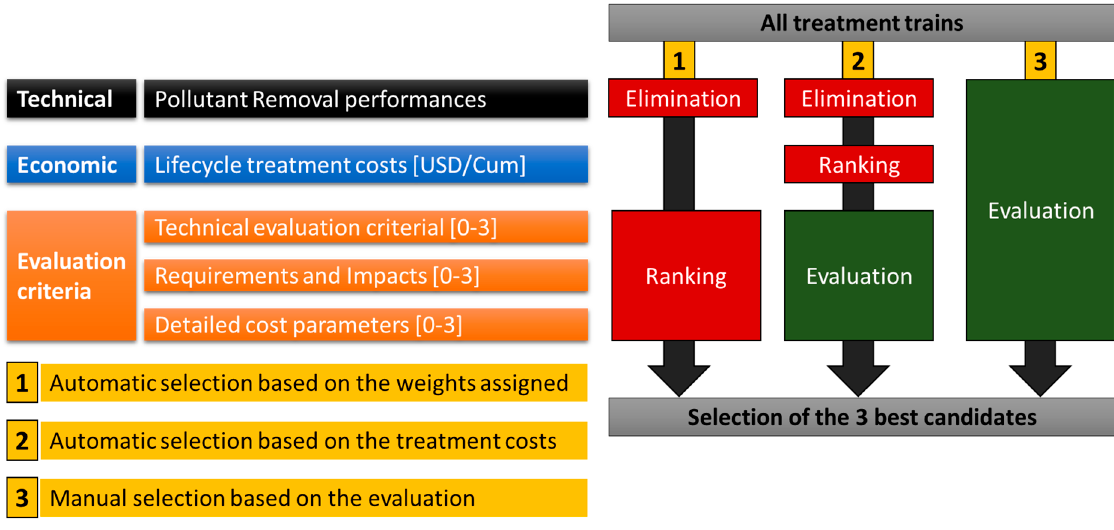
Figure 4. Assessment algorithm proposed by the stage II assessment.